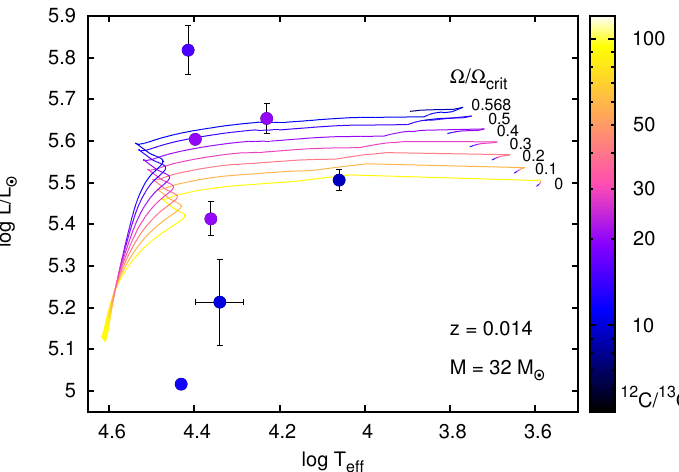
Figure 4. Evolution of the 12 C/ 13 C isotope ratio along the solar metallicity tracks of a star with initial mass of 32M (cid:12) and initial rotation speeds v / v crit ranging from 0 to 0.4 (corresponding to Ω / Ω crit = 0.0;0.1;0.2;0.3;0.4;0.5;0.568). The individual tracks have been obtained from the interpolation tool SCYCLIST provided by the Geneva group. For clarity of the plot, we truncated the evolutionary tracks within the red supergiant regions. Included are the positions of the MC B[e]SG sample from Table2 with known 12 C/ 13 C ratio, following the same color coding as for the tracks. The Galactic objects are excluded due to their highly uncertain luminosities. Depending on the initial rotation speed of the star, the observed ratio can be reached either in the pre-RSG (moderate rotator) or post-RSG (slow rotator)